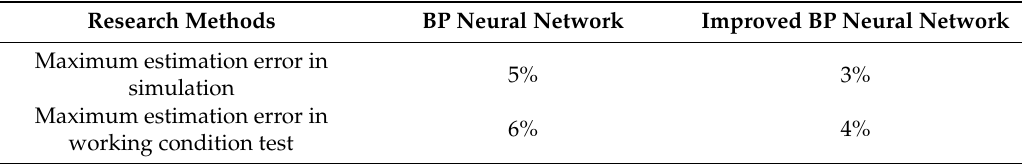
Table 2. Error comparison of the simulation analysis by different